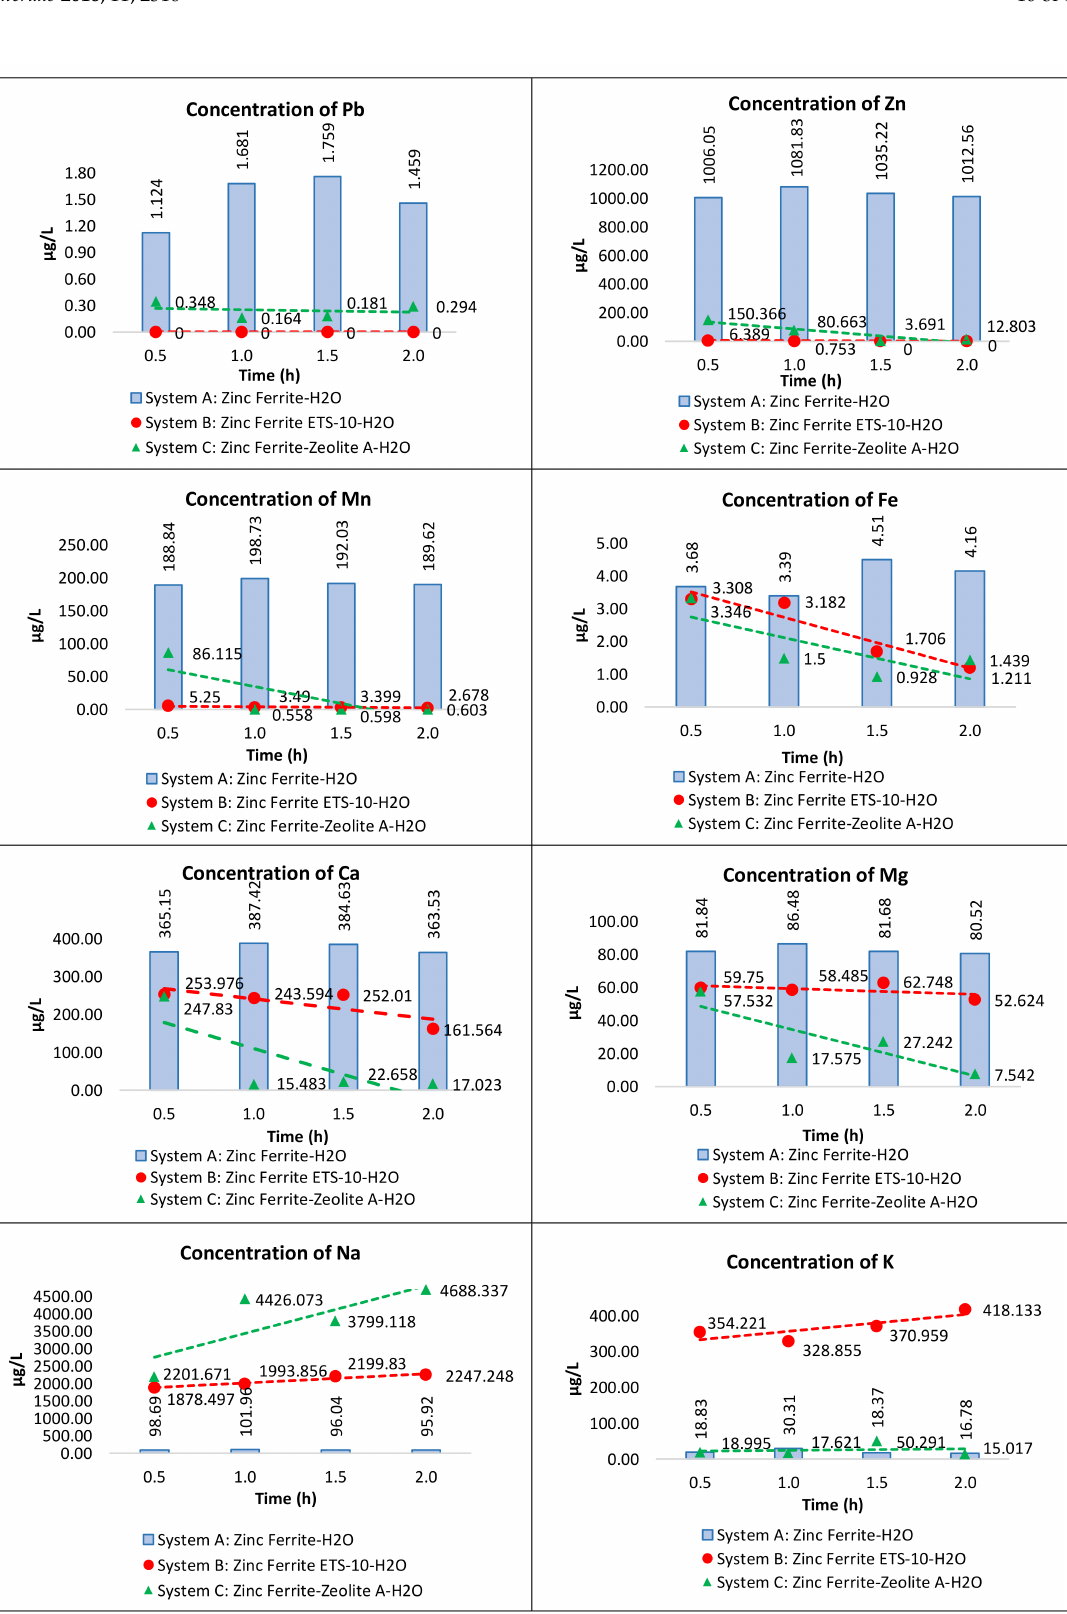
Figure 5. Comparison of the element concentration in System A (Zinc ferrite and water), System B (Zinc ferrite, ETS-10 and water) and System C (Zinc Ferrite, Zeolite A and